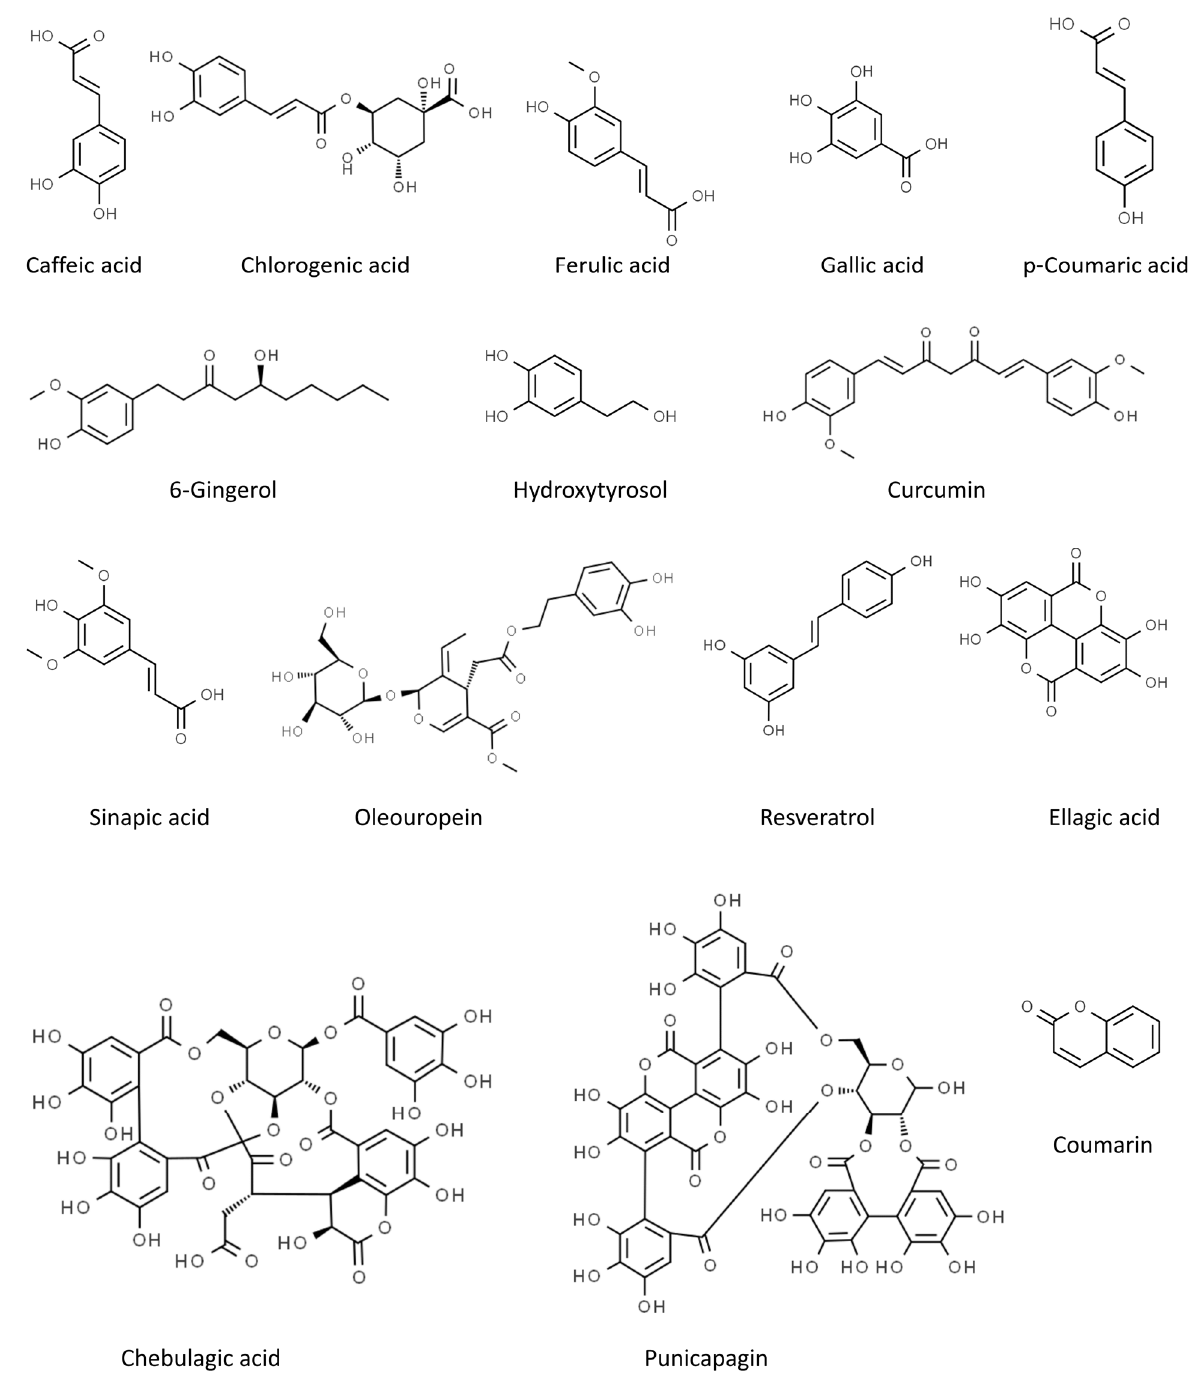
Figure 3. Chemical structure of the other selected phenolics (from ChemSpider, http://www.chemspider.com/ accessed on 24 February 2023).